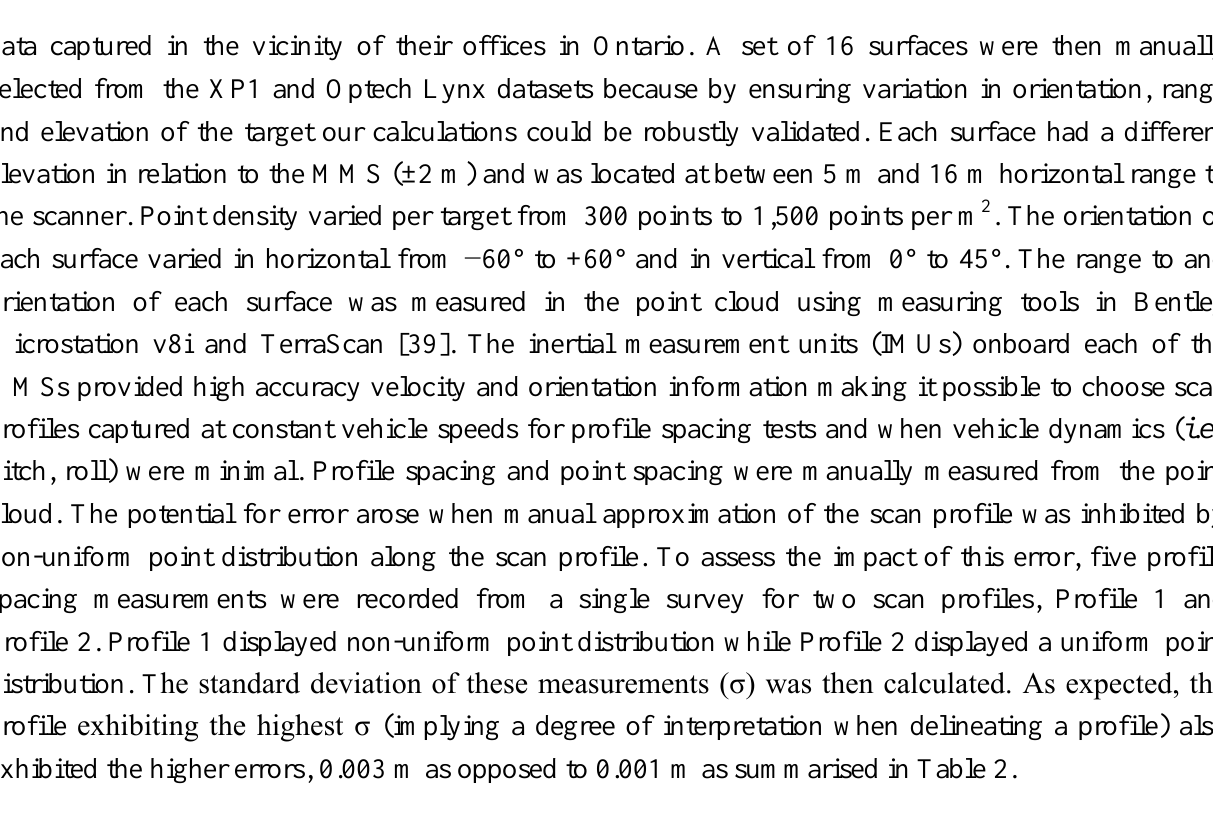
Table 2. Profile spacing tests- assessing the reliability of manual profile measurements as a validation tool for MIMIC-the importance of accurately delineating profiles in the point cloud is demonstrated by the positive correlation between σ and